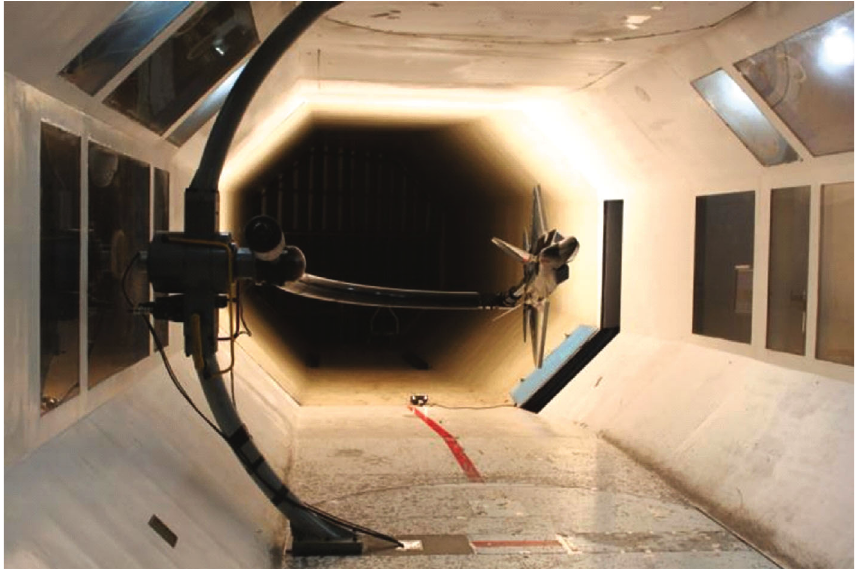
Figure 2: The FL-8 wind tunnel test system